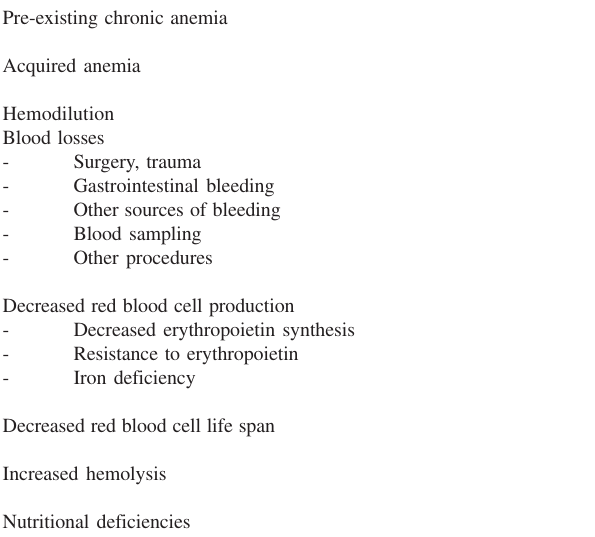
Table 1 - Causes of anemia in the intensive care unit patient Pre-existing chronic anemia Acquired anemia Hemodilution Blood